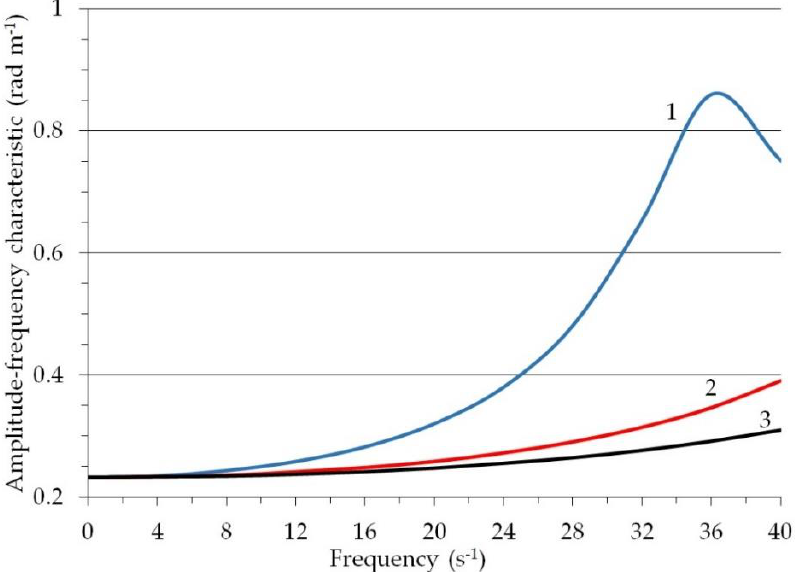
Figure 3. Amplitude – frequency characteristics of the dynamic system when examining the disturbance at different values of the tyre stiffness coefficient c of the tyre of the harvester ’s feeler wheels: curve 1, c = 115 kN m – 1 ; curve 2, c = 315 kN m – 1 ;curve 3. c = 515 kN m – 1 .